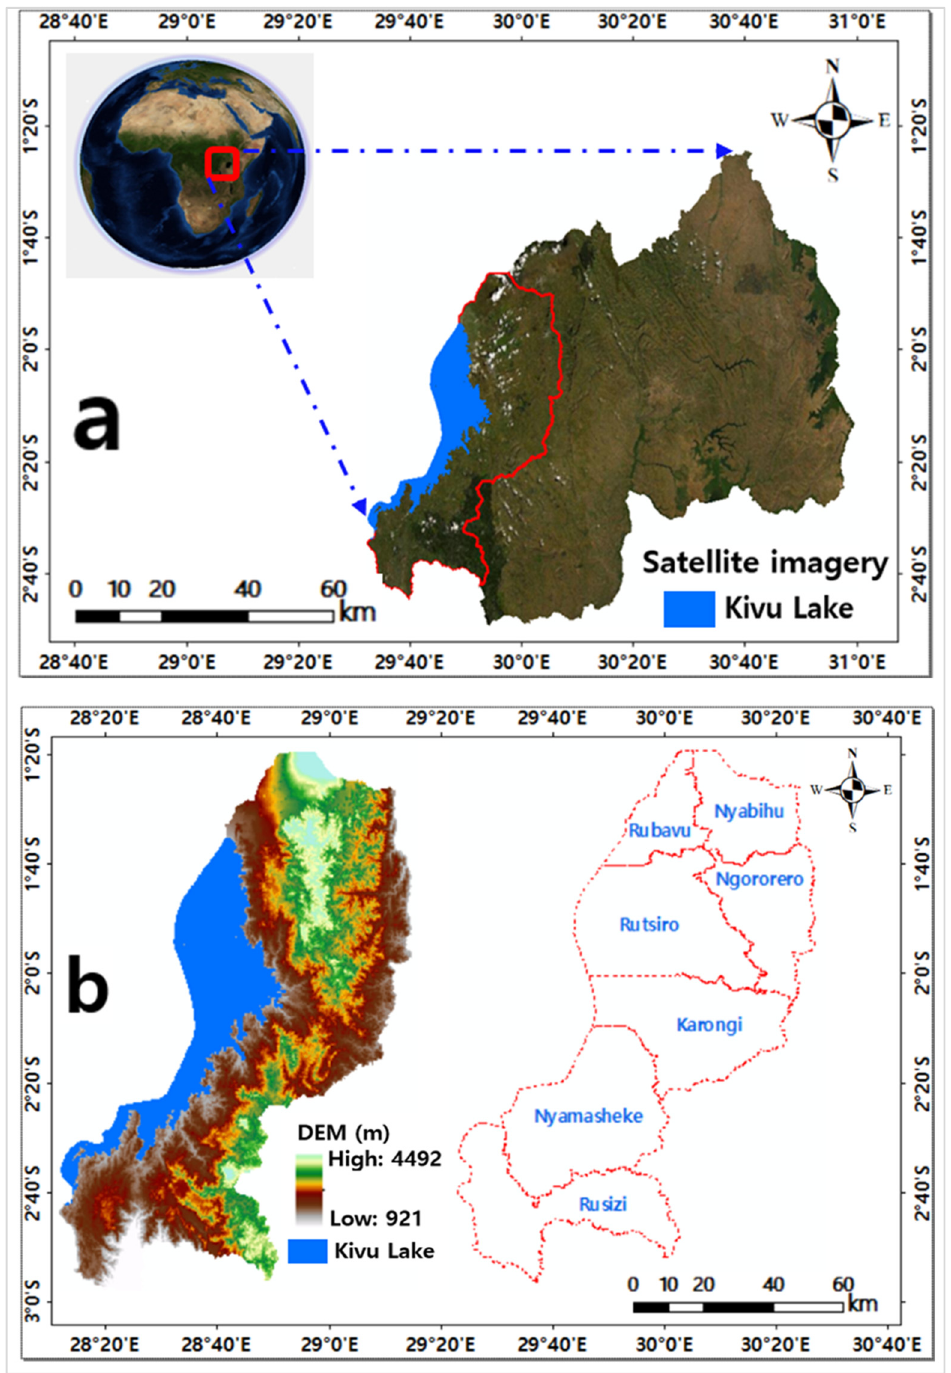
Figure 1. Location of the study area: ( a ) delimitation of the western province in Rwanda using satellite imagery; ( b ) digital elevation model with district boundaries of the study area.